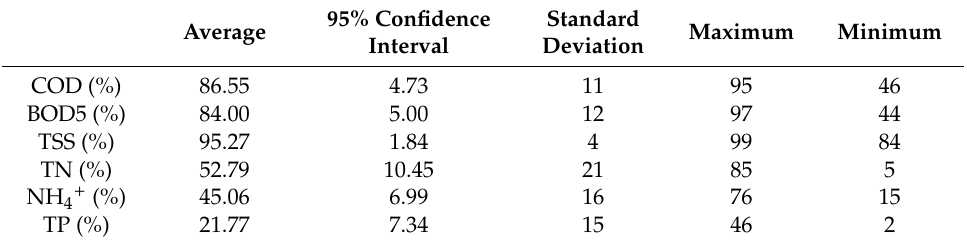
Table 4. Statistics of accumulated removal e ffi ciencies for the vertical flow constructed wetland (VFCW).